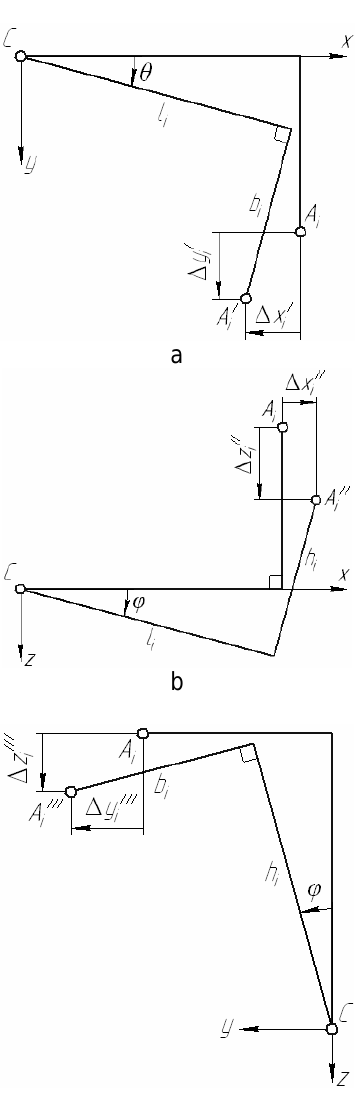
Figure 3. Geometric rations for determination the additional displacements: Δx i/ , Δy i/ (a); Δx i// , Δz i// (b); Δy i/// , Δz i/// (c) Parameters l i , b i , h i are local coordinates of locating elements 1, 2, …, 6, connected with global coordinates X i